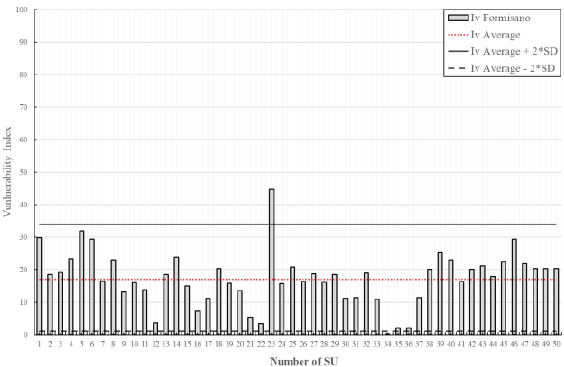
Figure 10. Results of the application of Formisano method.